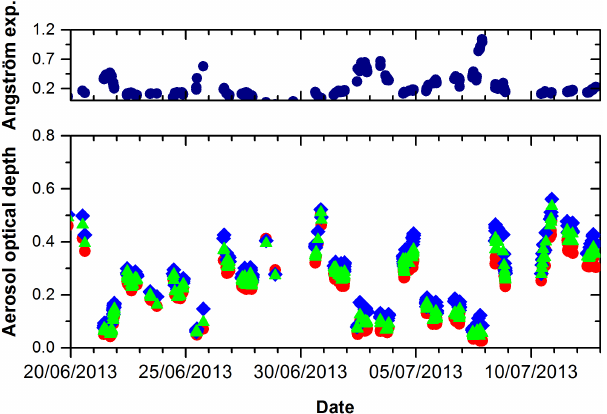
Figure 1. Angström Exponent between 440 and 870nm (upper panel) and the aerosol optical depth at 340 (blue), 500 (green) and 1020nm (red) derived from AERONET-CIMEL sun-photometer measurements at the Caribbean Institute for Meteorology and Hy- drology, Barbados (data: Barbados_SALTRACE) from 20 June to 13 July